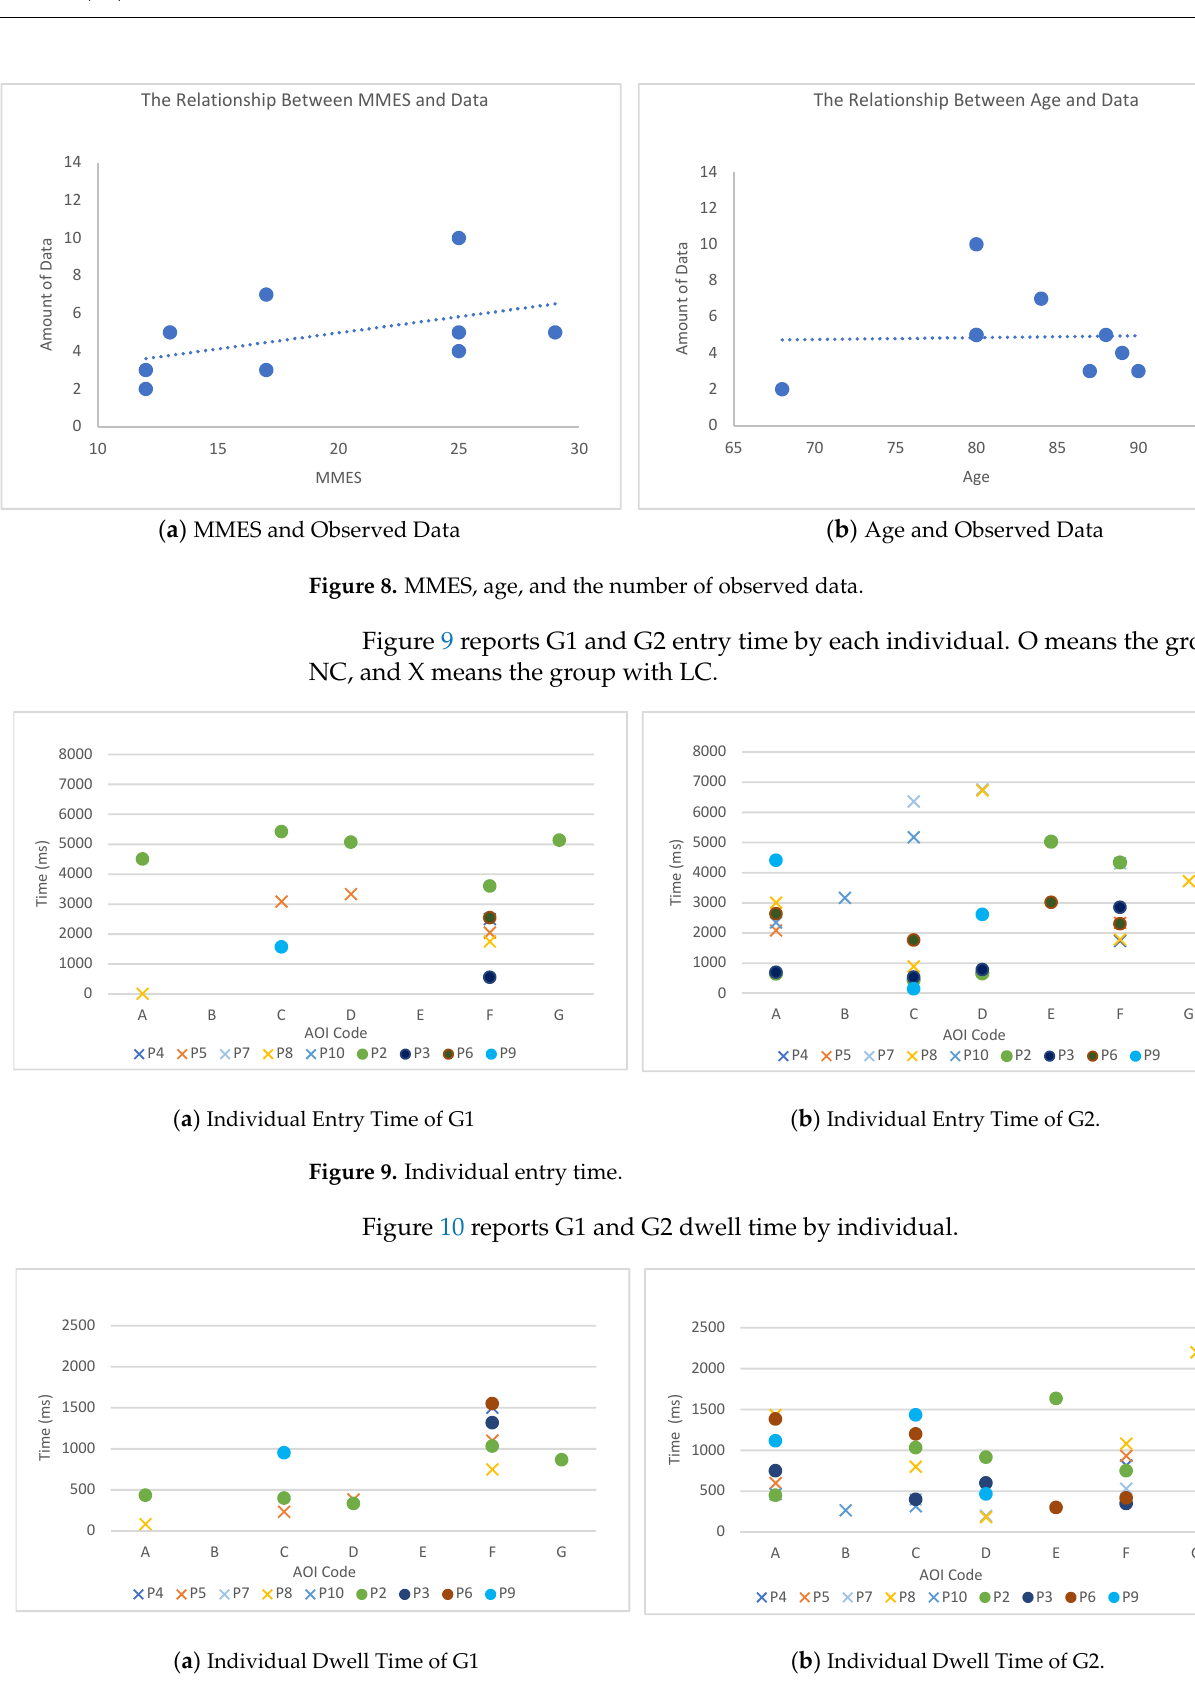
Figure 10. Individual dwell time.